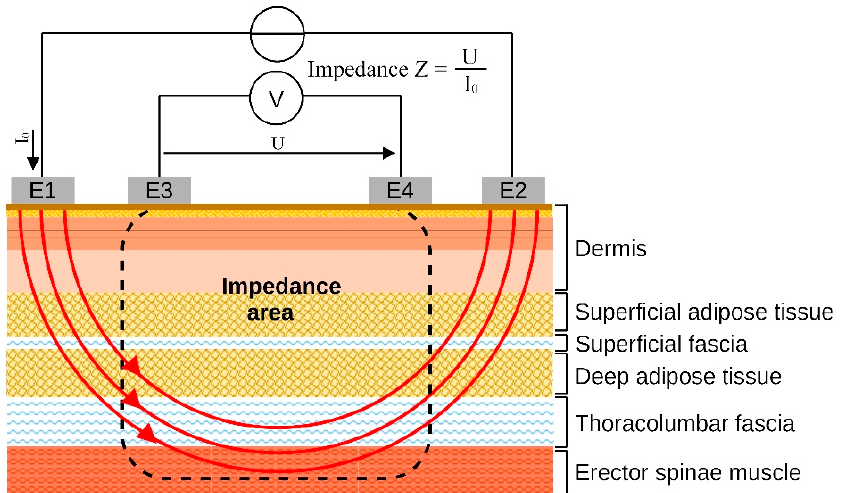
Figure 1. Four electrode method measurement of bioimpedance. E1,2, current electrode; E3,4, voltage electrode; V, voltameter; U, voltage; I 0 , current; Impedance area represents the current-carrying measured range.